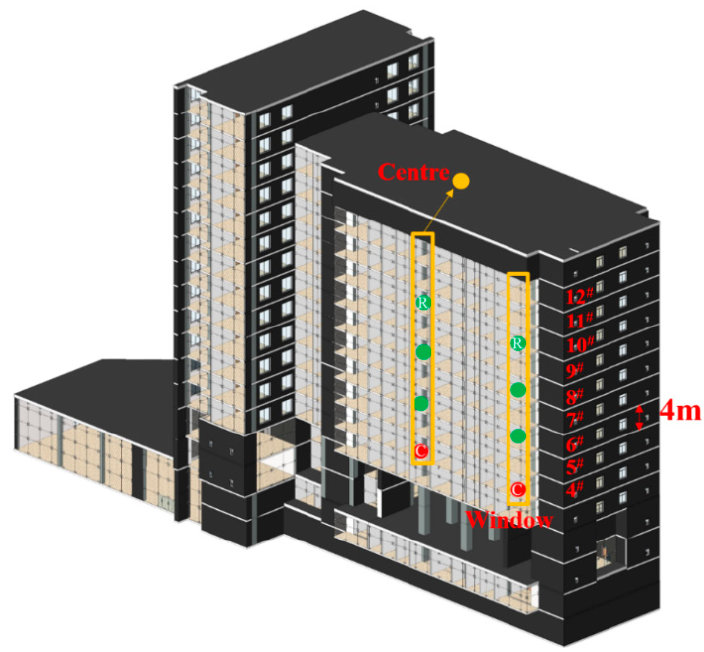
Figure 1. Sensors and wireless module used in IAQD.